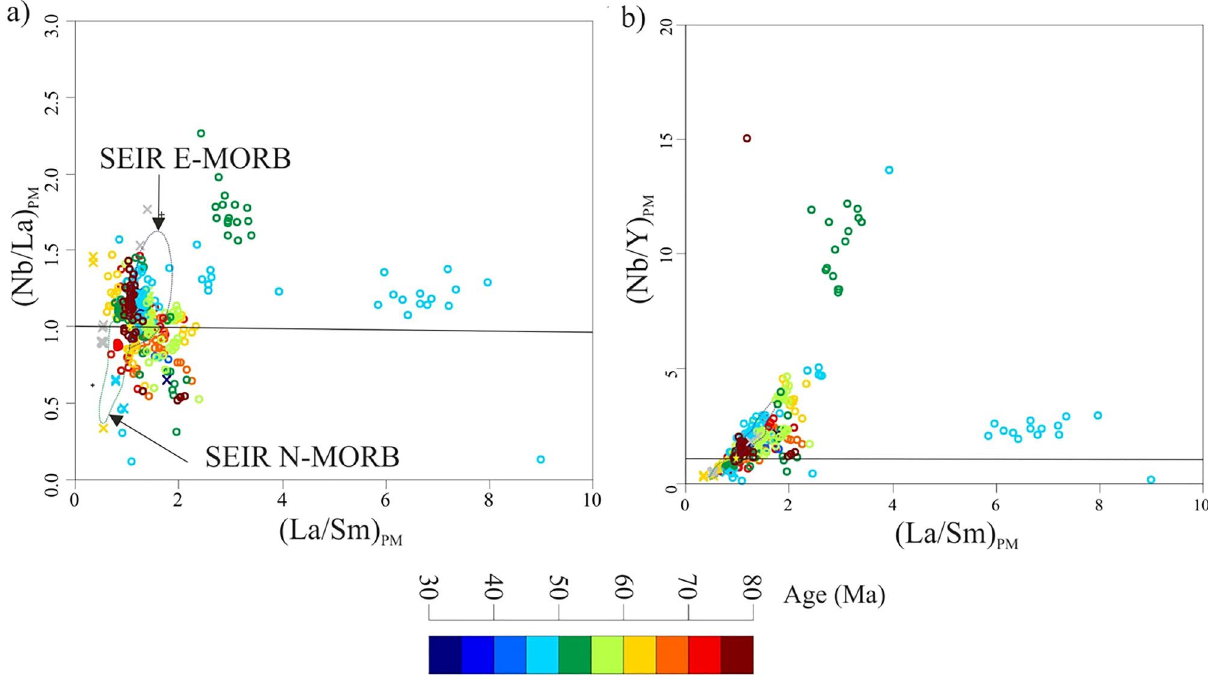
Figure 4. (La/Sm) PM vs. (Nb/La) PM and (Nb/Y) PM normalized to primitive mantle 64 ; where (Nb/Y) PM = 1 and (Nb/Y) PM = 1 at given (La/Sm) PM , are used to discriminate between SEIR N-MORB and SEIR E-MORB 54